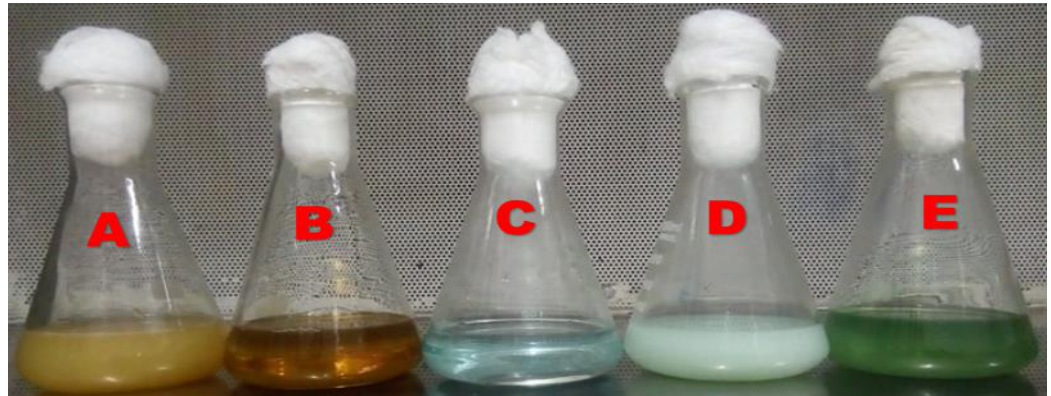
Figure 1. Observation of the color change in the reaction mixture of Pseudomonas fluorescens MAL2 during the biosynthesis of CuNPs: ( A ) P. fluorescens MAL2 in F-Base medium. ( B ) Cell-free extract supernatant. ( C ) CuSO 4 ·5H 2 O solution. ( D ) One gram of cell pellet added to CuSO 4 ·5H 2 O. ( E ) Color change in the reaction mixture from blue to dark green indicating the formation of CuNPs.